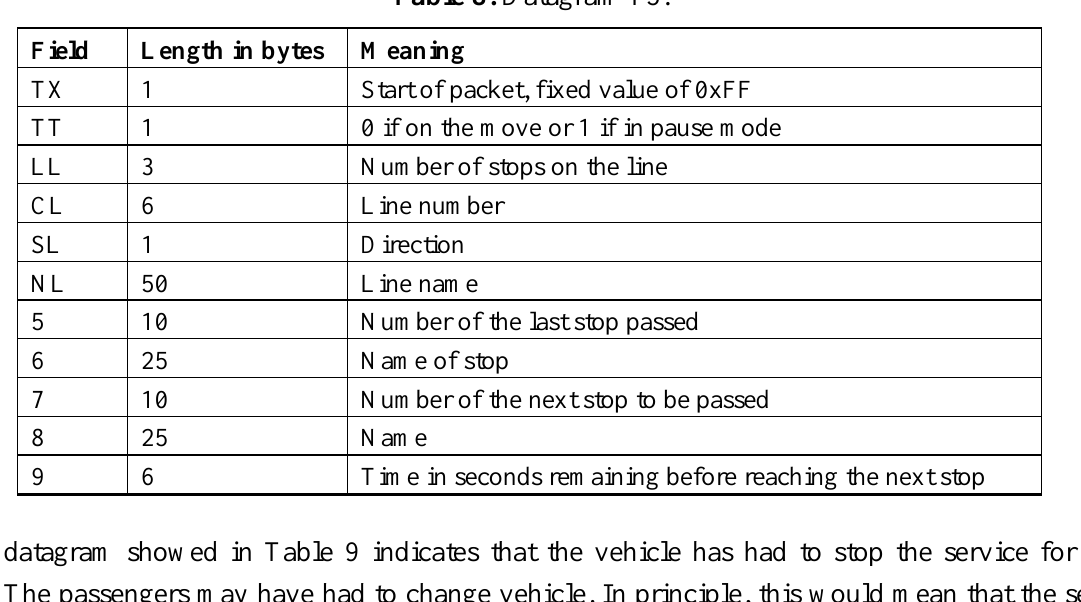
Table 8. Datagram T5.